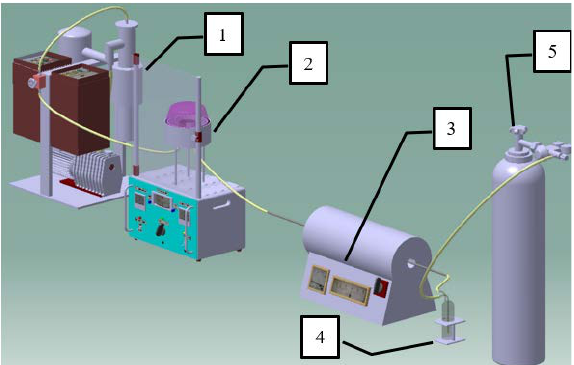
Figure 2. Principle diagram of the experimental installation used for nitriding: (1) vacuum pump, (2) nitriding installation, (3) ammonia dissociation furnace, (4) flow meter, and (5) ammonia gas tank.